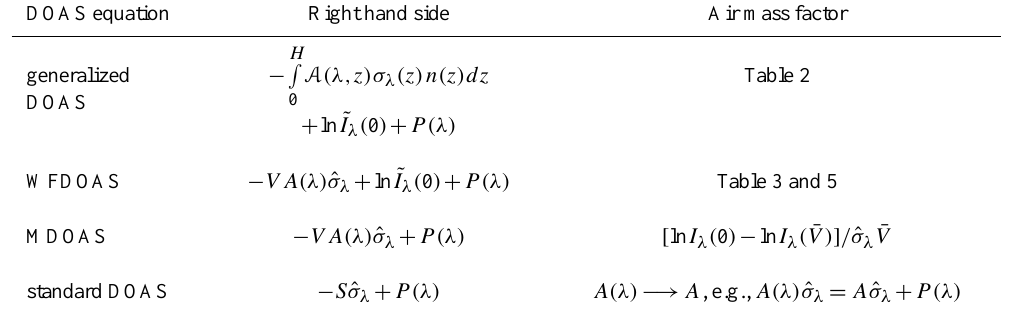
Table 6. DOAS equations considered in this study and corresponding AMFs. All DOAS equations have ln I λ (k) in their left hand sides. DOAS equation Right hand